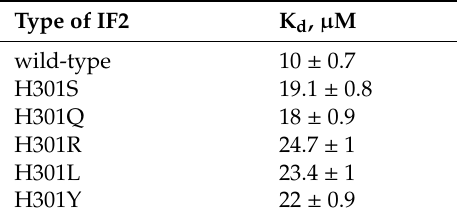
Table 1. E ff ect of the IF2H301 mutations on the Kd’s of the IF2-mantGTP complexes.